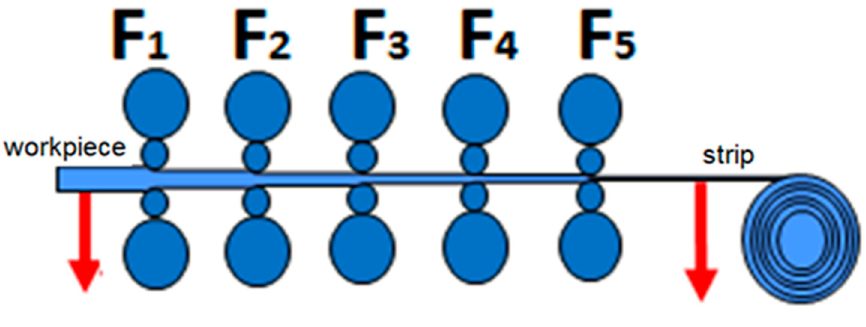
Figure 2. Layout of sampling from the continuous group of the “Quarto 2800” hot rolling mill.